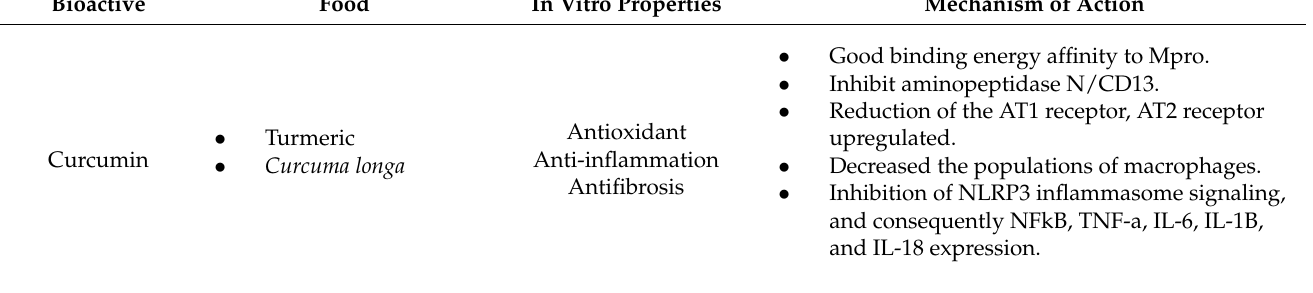
Table 1. Summary of the bioactive compounds selected and potential mechanisms of action. Bioactive